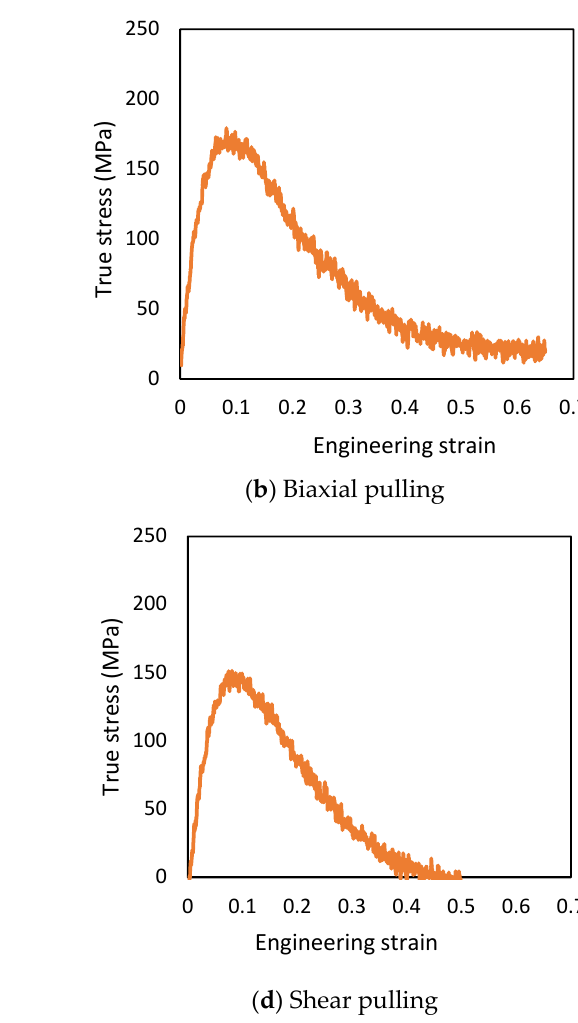
Figure 5. Stress–strain curves with different combined stress states (z-axis).